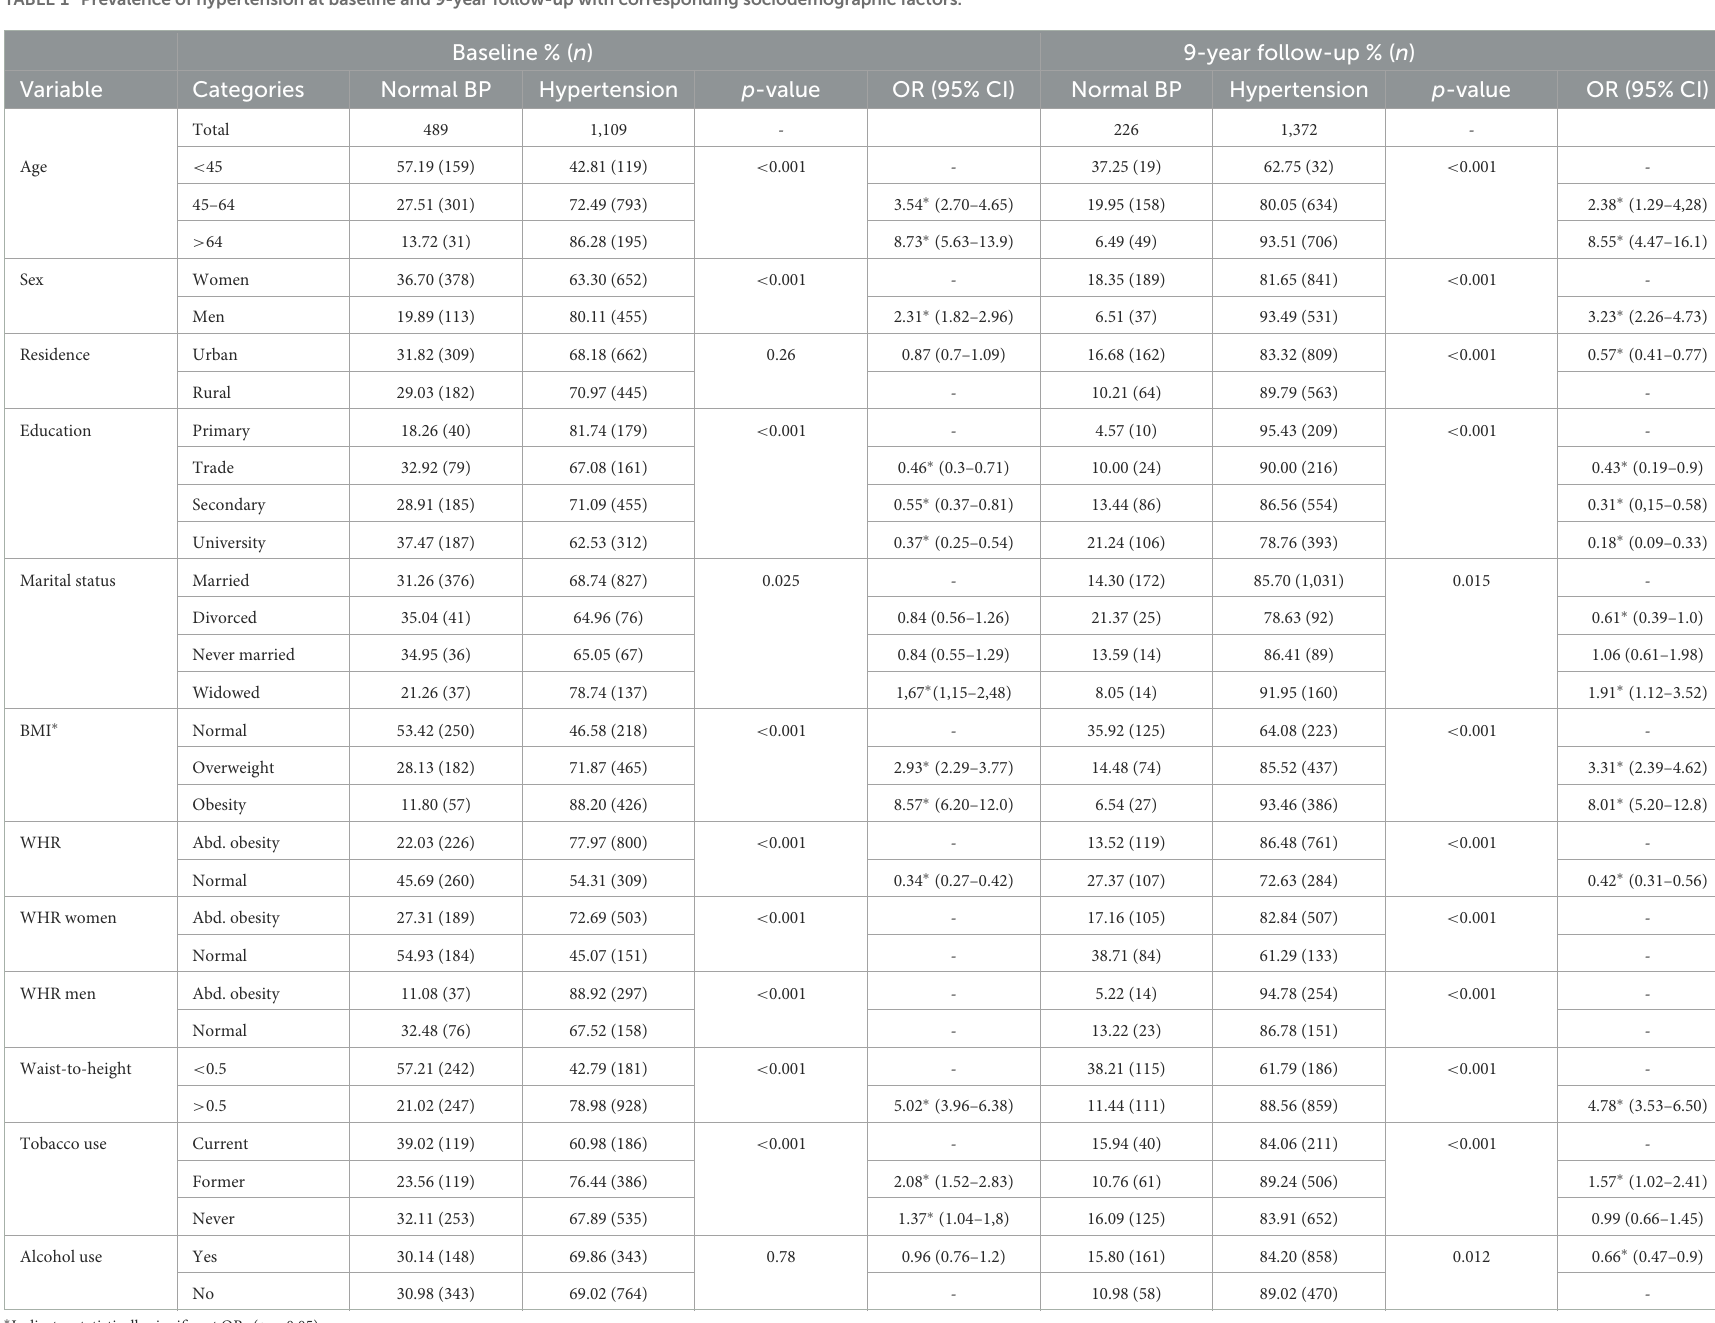
∗ IndicatesstatisticallysignificantORs( p <